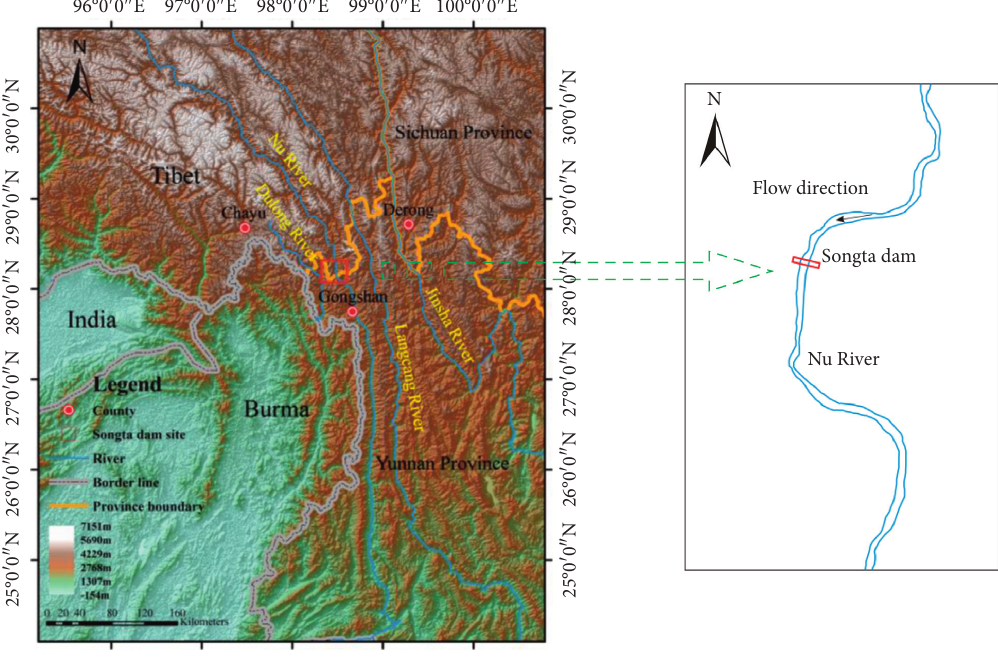
Figure 3: Topographic and location map of the study case.